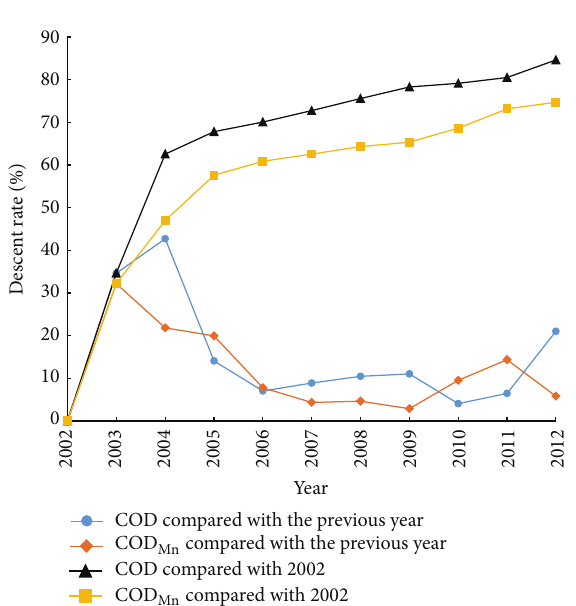
Figure 5: The descent rate of pollutants concentration in the Nansi Lake Basin during 2002 ∼